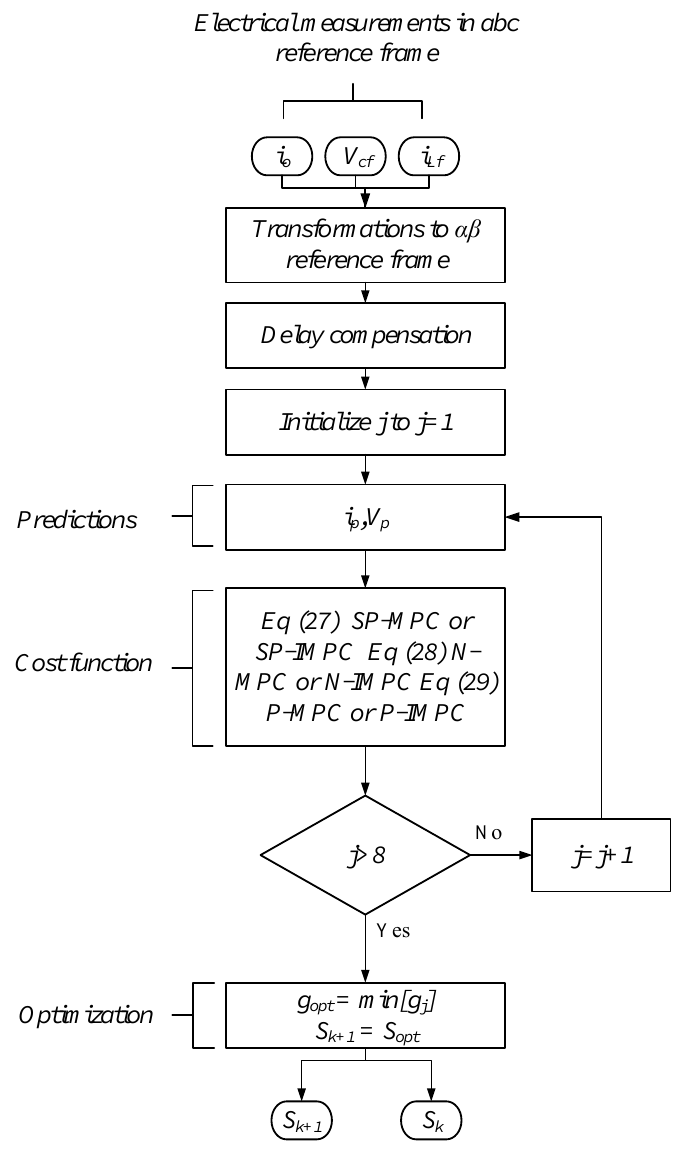
Figure 6. Flowchart of the implemented algorithms using